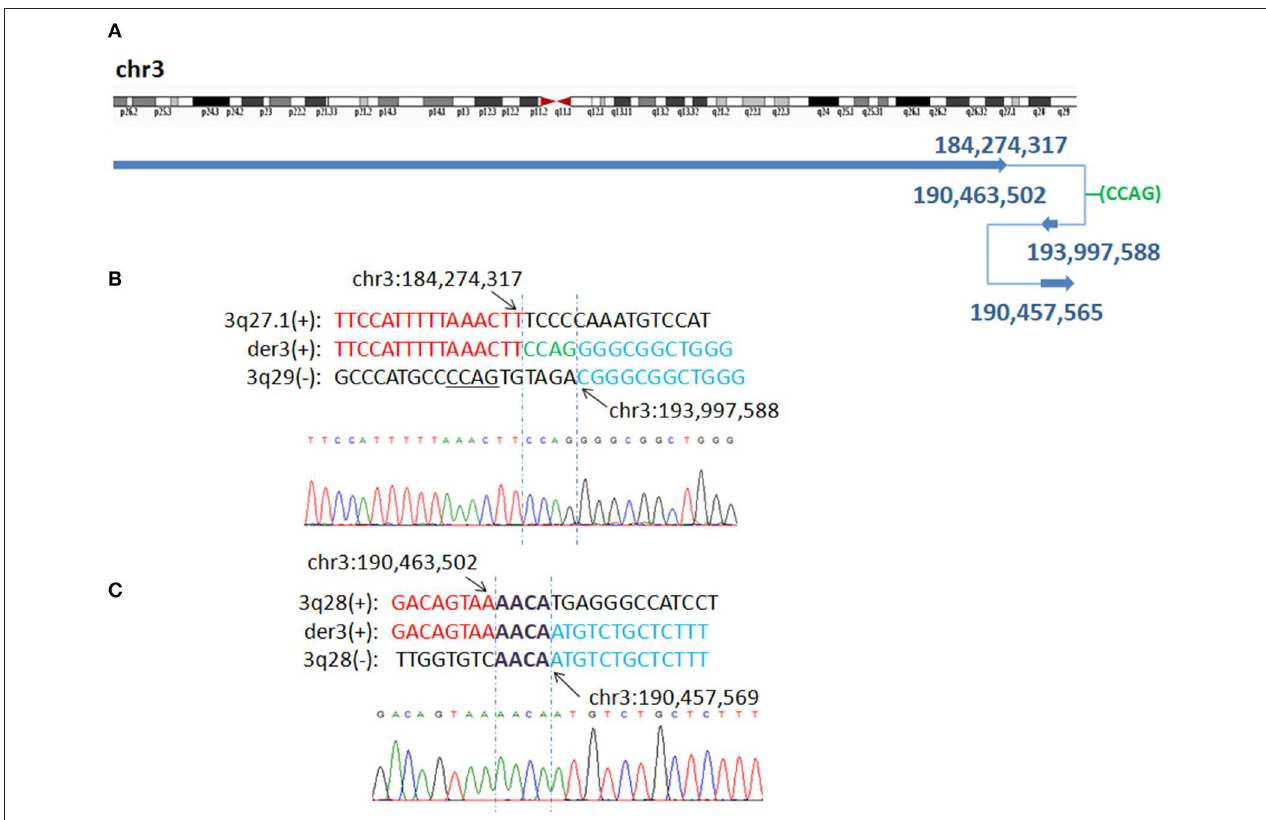
FIGURE 3 | P7 with interstitial deletion/duplication rearrangements. (A) Breakpoints analysis and validation found four breakpoints in patient 7: chr3q27.1: 184,274,317, 3q29:193,997,588, 3q28:190,463,502 and 3q28:190,457,565. There is a 4 bp insertion of unknown origin between chr3q27.1: 184,274,317 and 3q29:193,997,588 fusion breakpoint. (B) The breakpoint junction 1 mapped at the base-pair level by Sanger sequencing. Rearrangement junction sequences (middle line) and matching reference sequences (top and bottom lines) are shown with different colors depending on the involved chromosome region (3q27.1-red, 3q29-blue). Green letter, insertion. Sequnece with black underline indicate the potential origin if the insertion at junction 1. (C) Rearrangement junction 2 sequence (middle line) and matching reference sequences (top and bottom lines) are shown with different colors depending on the involved chromosome region (3q28 tel-red, 3q28 cen-blue). The breakpoint site is indicated in blue line. Der3( + ) indicates the junction sequences near the centromere. Sequences in bold purple represent microhomology.